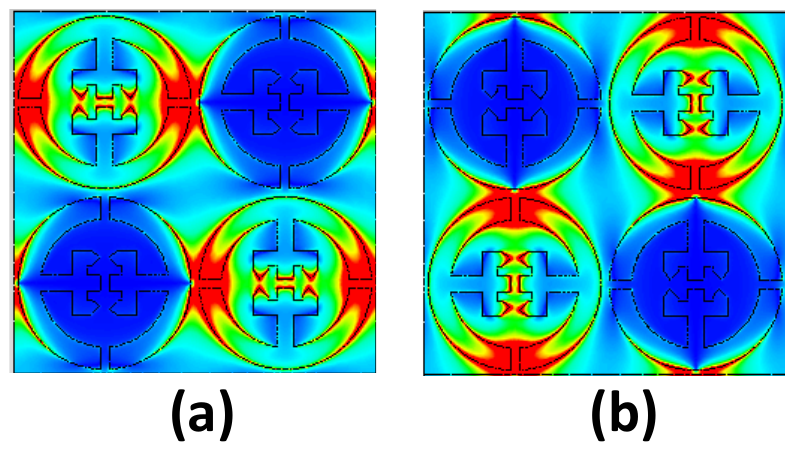
Figure 6. Numerical results showing the magnitude of the E-field across the surface of the 2 × 2 supercell for ( a ) polarization 1, and ( b ) polarization 2.